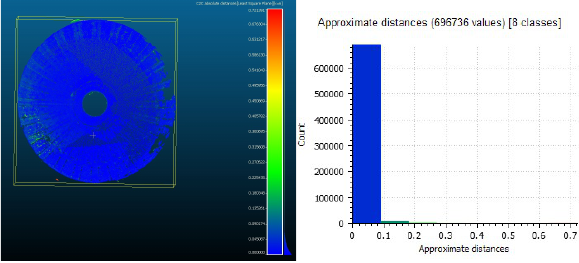
Figure 12: Discrepancy (m) map and histogram between the TLS point cloud and Powershot – Medium processing.